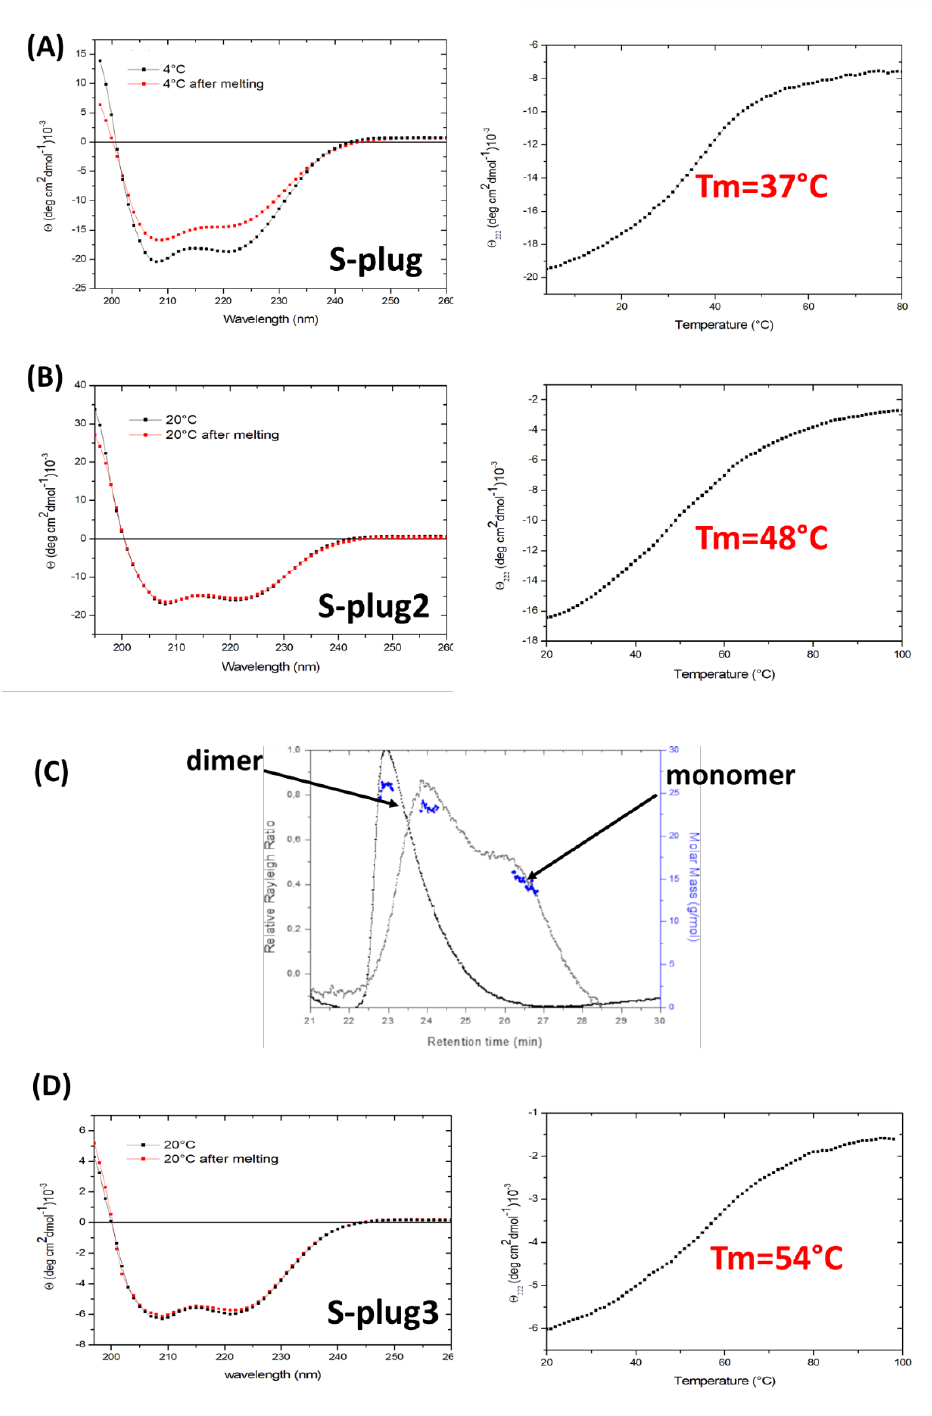
Figure 3. Thermostability and light scattering studies. ( A , B , D ) Far-UV CD spectra (left) and thermal denaturation curves monitored at 222 nm (right) for S-plugs. All spectra were measured at 0.2 mg mL-1 in in 20 mM sodium phosphate buffer (pH 7.4). The panel ( C ) reports the analytical SEC-LS of S-plug (grey) and S-plug2 (black). Relative Rayleigh ratios (left scale) and derived molar masses (right scale, blue) are plotted versus elution time.